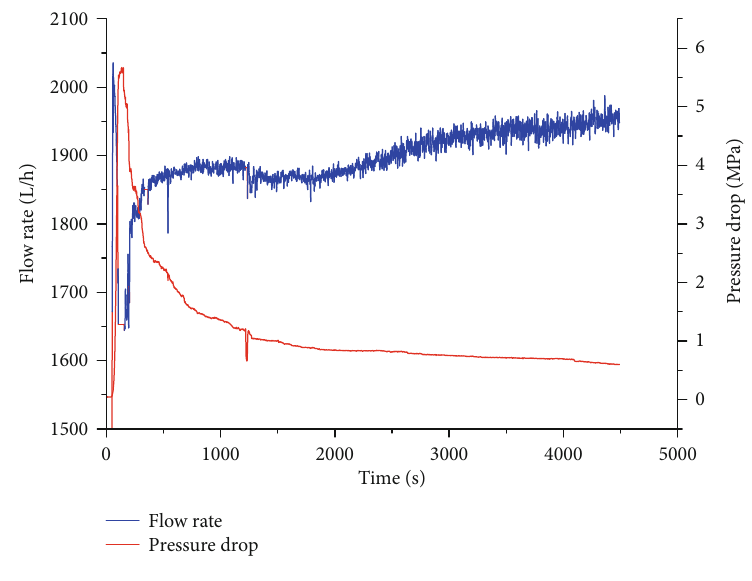
Figure 10: Experimental fl ow test curve ( NTG = 1 ). Table 2: Experiment of the e ff ect of NTG on the sand blocking screen plugging rule under a vertical wellbore. Sand control method